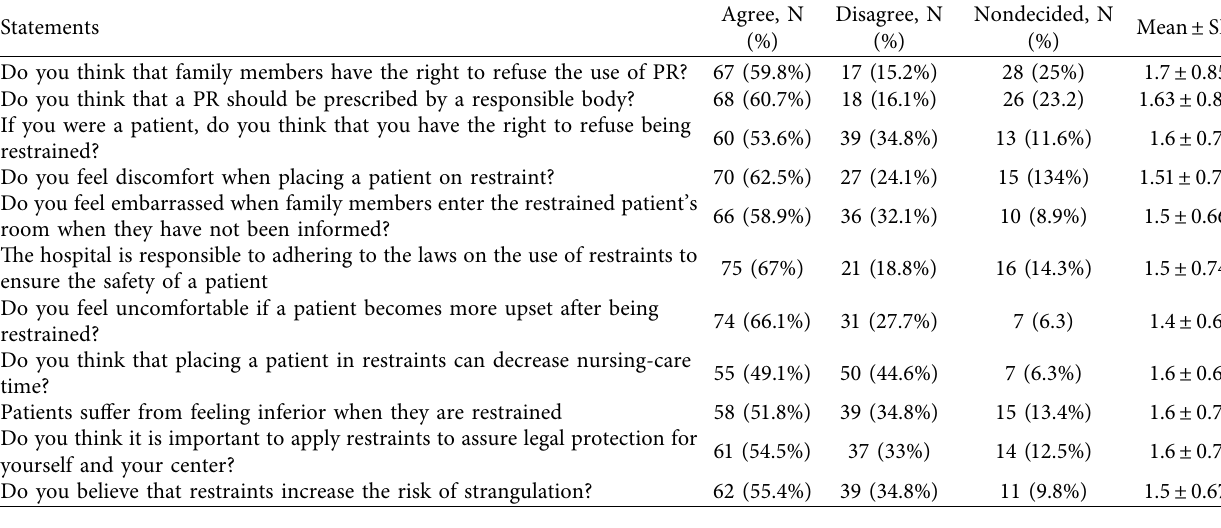
Table 3: Selected items measuring participant nurses’ attitude regarding physical restraint use at federally administered hospitals in Addis Ababa, 2019 ( n � 112) ( n � 112).